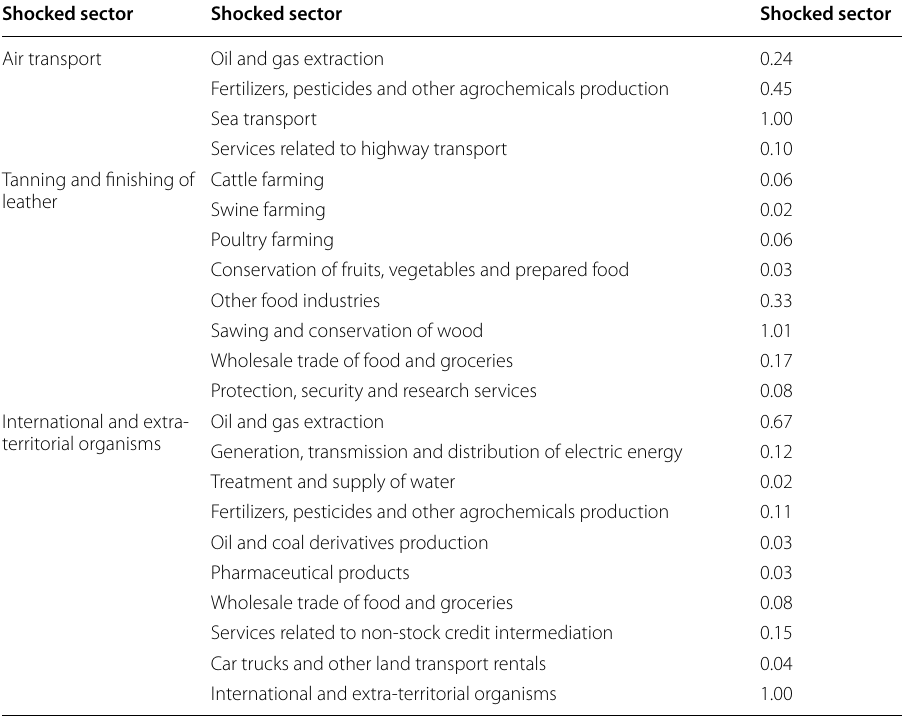
Table 4 Top ranked sectors according to aggregate effect and diffusion (2008). Source: Results from authors